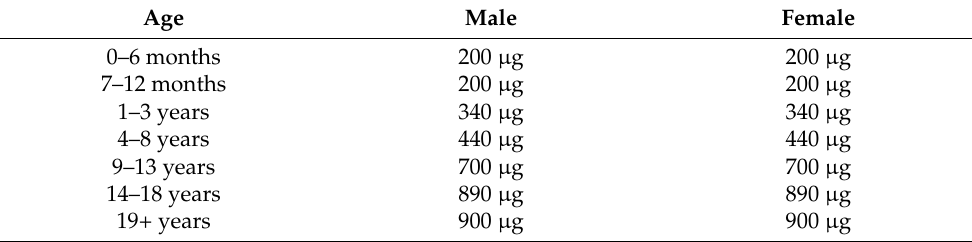
Table 2. Recommended daily copper allowance